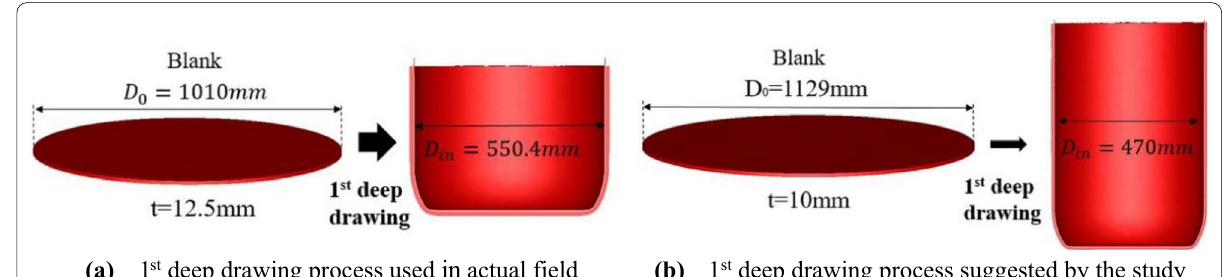
Figure 17 FEA results of 1 st deep drawing process